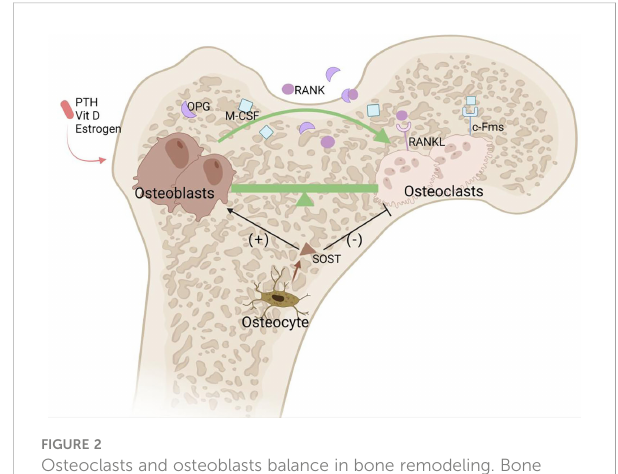
FIGURE 2 Osteoclasts and osteoblasts balance in bone remodeling. Bone remodeling is an orderly and coupled process of bone resorption and bone formation mediated respectively by osteoclasts and osteoblasts. RNAKL/RANK and M-CSF/c-Fms are the two most important pathways governing osteoclast proliferation and differentiation. OPG can bind to RANKL, inhibiting the interaction between RANKL and RANK. Estrogen, vitamin D, and small doses of PTH from the circulation can promote bone formation. Osteocytes also secrete SOST, which negatively regulates osteoblasts and positively regulates